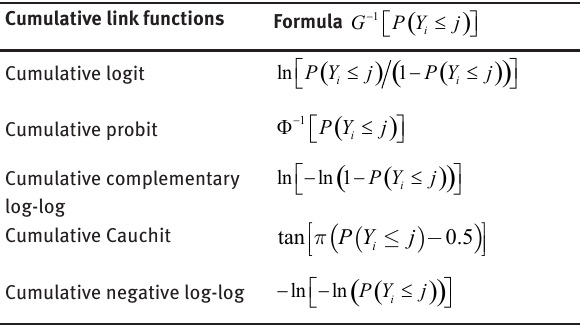
Table 2: Cumulative link functions belonging to the ordinal response variable in the GLM from the multinomial distribution.